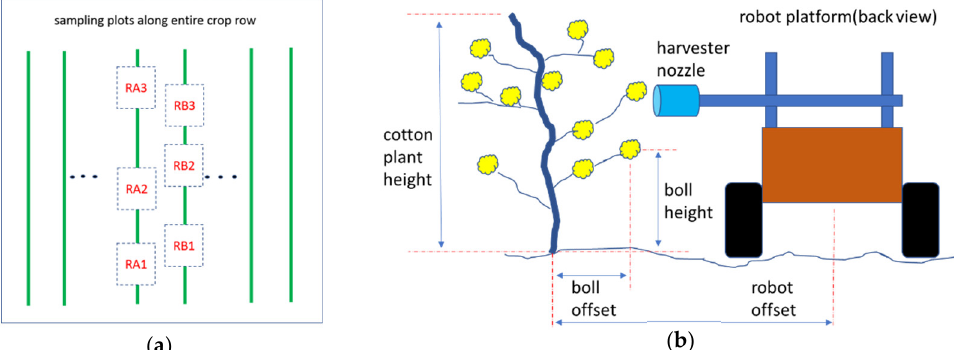
Figure 12. Random sampling plot design for cotton boll harvesting in ( a ) and sampling measurements for boll position to determine the position of the fixed nozzle in ( b ).